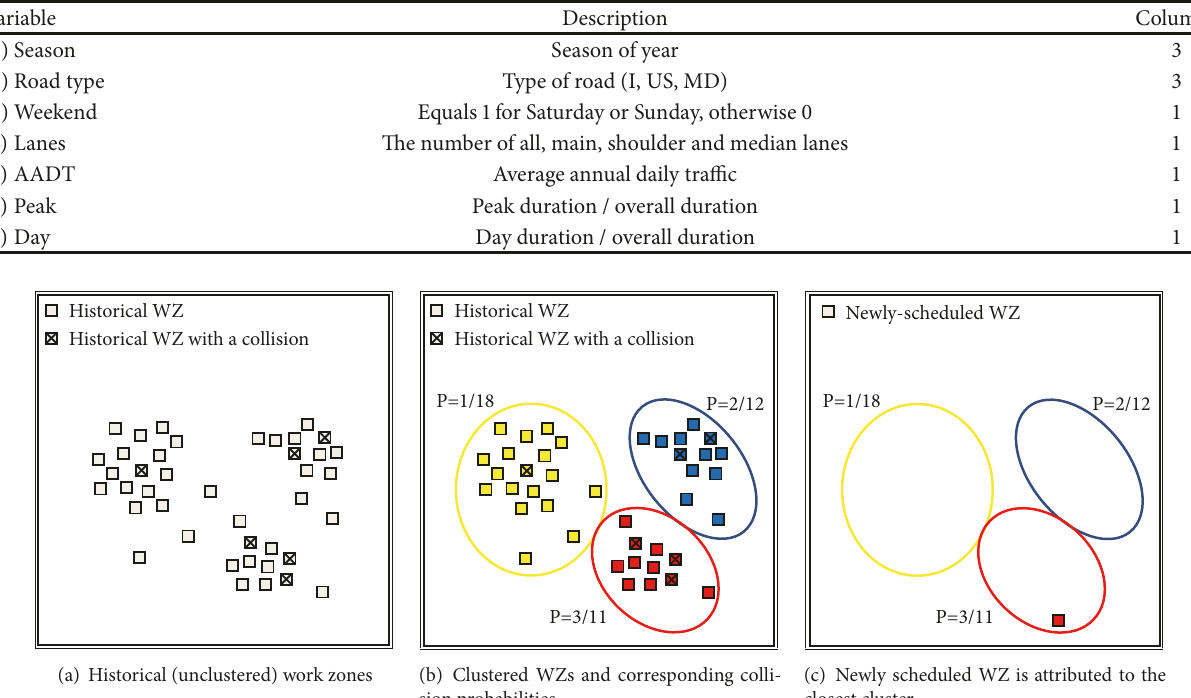
Table 2: Input variables used for WZ clustering.